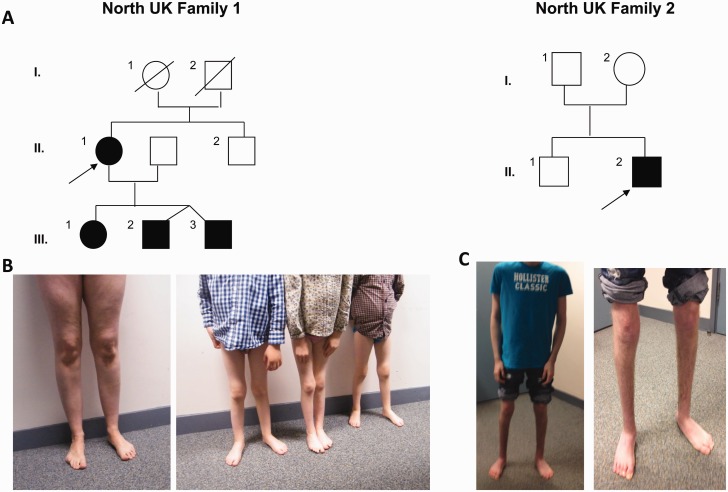
Pedigrees and clinical presentations of 2 new families carrying the p.Ser107Leu mutation in BICD2. (A) Pedigrees of the North UK families. Probands of each family are indicated by an arrow. (B) Image of the proband and her three affected children from Family 1 presenting with lower limb wasting and feet deformities. (C) Images of proband from Family 2 demonstrating wasting of lower extremities and his postsurgical feet position.